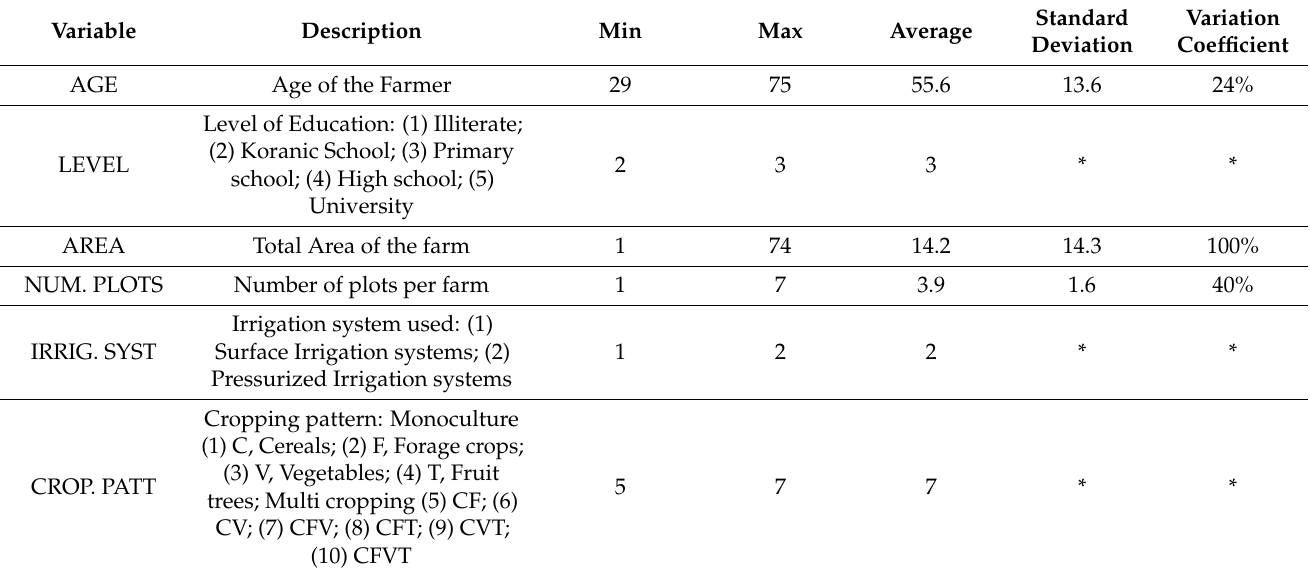
Table 1. Variables and descriptive statistic data of the farmers’